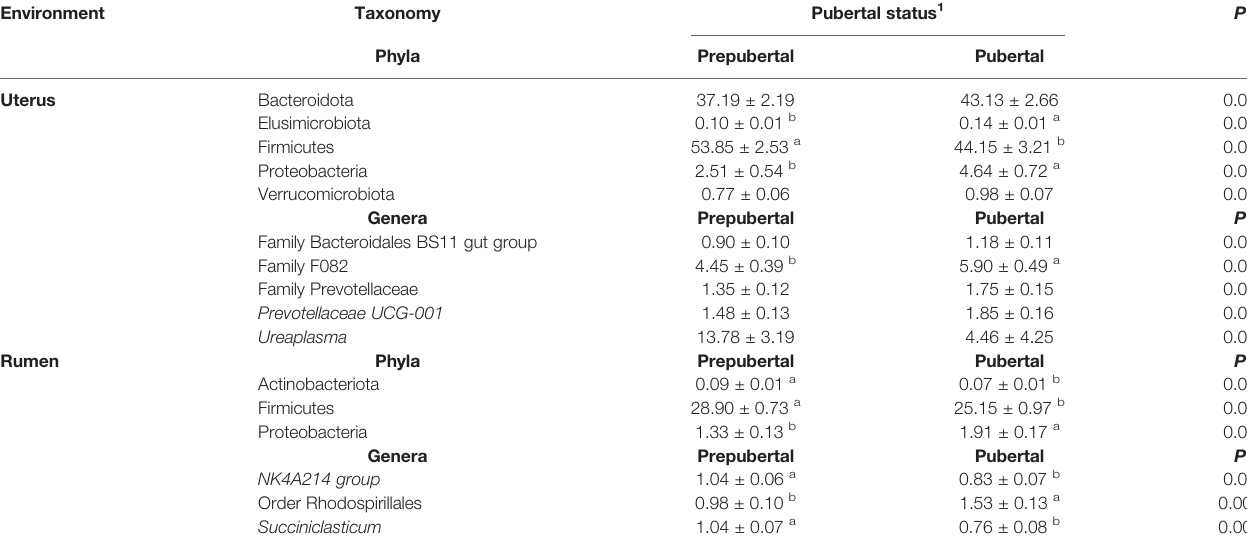
TABLE 3 | Bacterial phyla and genera with relative abundance ≥ 1% in the uterus and rumen impacted by pubertal status.